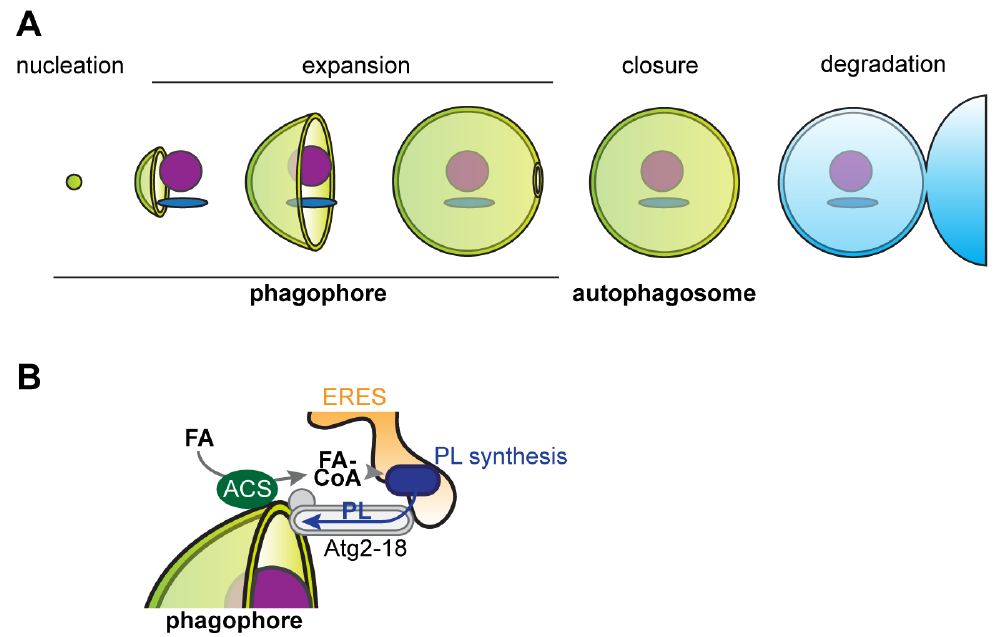
Figure 1. Autophagosome biogenesis. ( A ) The stages of the life cycle of an autophagosome. ( B ) Model for the role of local fatty acid (FA) activation, de novo phospholipid (PL) synthesis, and Atg2-mediated PL transfer during phagophore expansion. ACS, acyl-coenzyme A synthetase; CoA, coenzyme A; ERES, endoplasmic reticulum exit